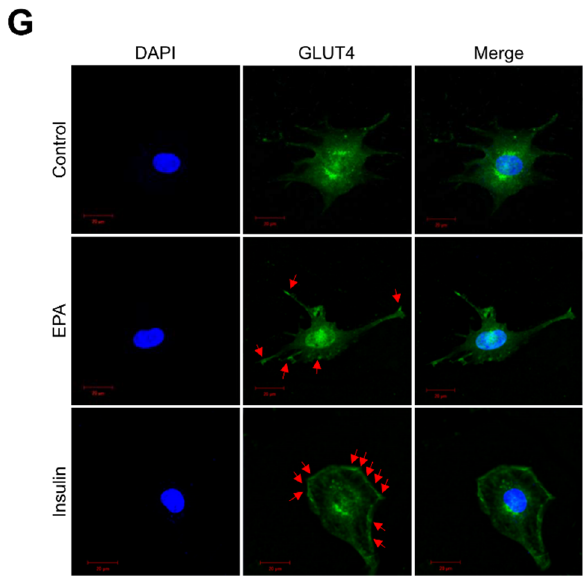
Figure 2. T EPA stimulates glucose uptake through the AMPK signaling pathway in C2C12 myoblasts. ( A ) Western blot analysis of AMPK α and ACC phosphorylation in C2C12 cells treated with various concentrations of EPA for 3 h or ( B ) 30 µ M EPA for the indicated times. Total protein levels for AMPK α , ACC and β -actin were used as loading controls. ( C ) 2-deoxy-d[H 3 ]-glucose (2-DG) uptake measured in L6 cells di ff erentiated for 7 days and treated with 50 µ M EPA for the indicated times. ( D ) Cell surface expression of Myc-GLUT4 quantified using an antibody-coupled colorimetric absorbance assay in myoblasts stably expressing L6-GLUT4-myc, di ff erentiated for 7 days, and treated with EPA or 100 nM insulin for 3 h. ( E ) Di ff erentiated L6 myotubes treated with 50 µ M EPA for 3 h in either the presence or absence of compound C (5 µ M). ( F ) Di ff erentiated L6-myc-GLUT4 cells were pre-treated with compound C for 30 min, and then incubated with EPA for 3 h. The Myc-GLUT4 expression in cells is quantified using an absorbance assay. ( G ) Representative images (GLUT4, DAPI, and merge) of cells treated with EPA for 3 h. Insulin (100 nM) was used as positive control. Scale bar, 20 µ m. * p < 0.05, ** p < 0.01 compared to untreated cells. Results from three independently replicated experiments are presented.